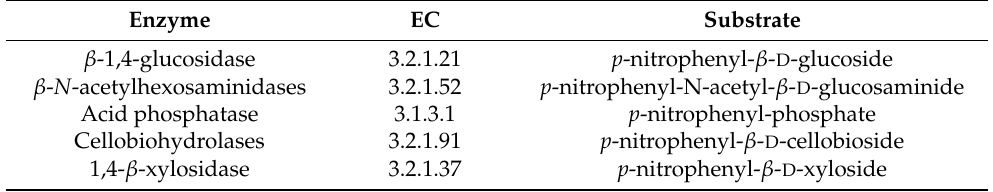
Table 1. Enzymes and substrates related to carbon (C), nitrogen (N), and phosphorus (P) cycles. Enzyme EC Substrate β -1,4-glucosidase 3.2.1.21 p -nitrophenyl- β - D -glucoside β - N -acetylhexosaminidases 3.2.1.52 Acid phosphatase 3.1.3.1 p -nitrophenyl-phosphate Cellobiohydrolases 3.2.1.91 p -nitrophenyl- β - D -cellobioside 1,4- β -xylosidase 3.2.1.37 p -nitrophenyl- β - D